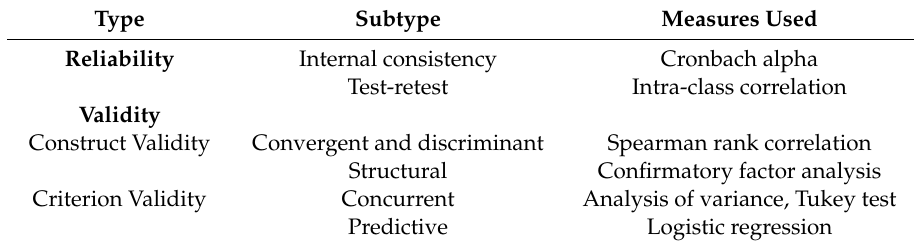
Table A1. Summary of methods used in the testing of the reliability and validity of Physical Component Summary Score and Mental Component Summary Score in Short Form 12-Item Survey version − 2 among an older (65 years or greater) US